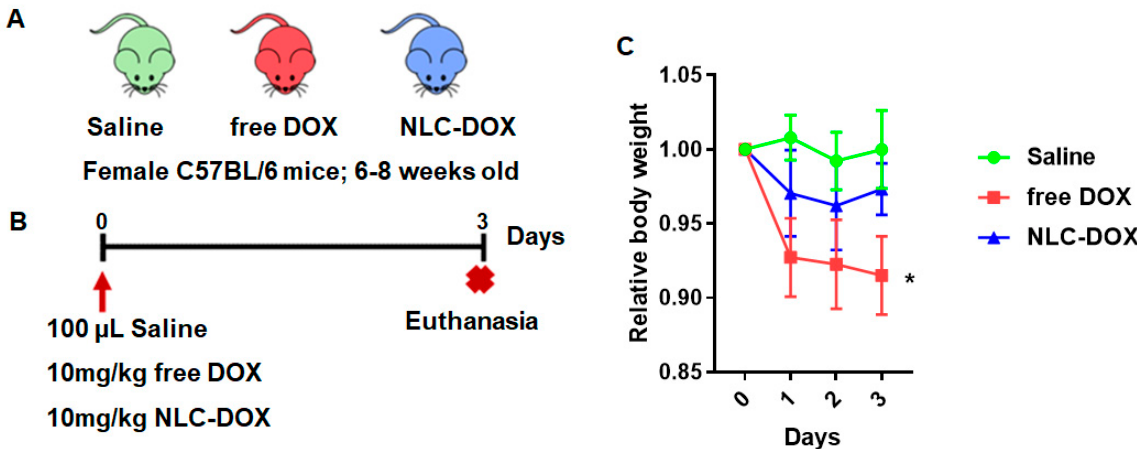
Figure 4. NLC-DOX prevents DOX-induced weight loss. ( A ) C57BL/6 mice were randomly allocated to 3 groups, Saline, free DOX and NLC-DOX (n = 5 animals/group). ( B ) Animals were injected with free DOX, NLC-DOX or saline and followed for 3 days. ( C ) Weight variation of the animals during the 3-day follow-up. The animals were weighed daily, the first weighing was performed on day zero of the protocol and the average weight per group analyzed was considered for analysis. Statistical analysis was performed by using the ANOVA test, followed by the Tukey test. * p < 0.05. N = 20 animals per group. Data are a pool from 4 experiments performed. Abbreviations: DOX, doxorubicin; NLC, nanostructured lipid carrier.